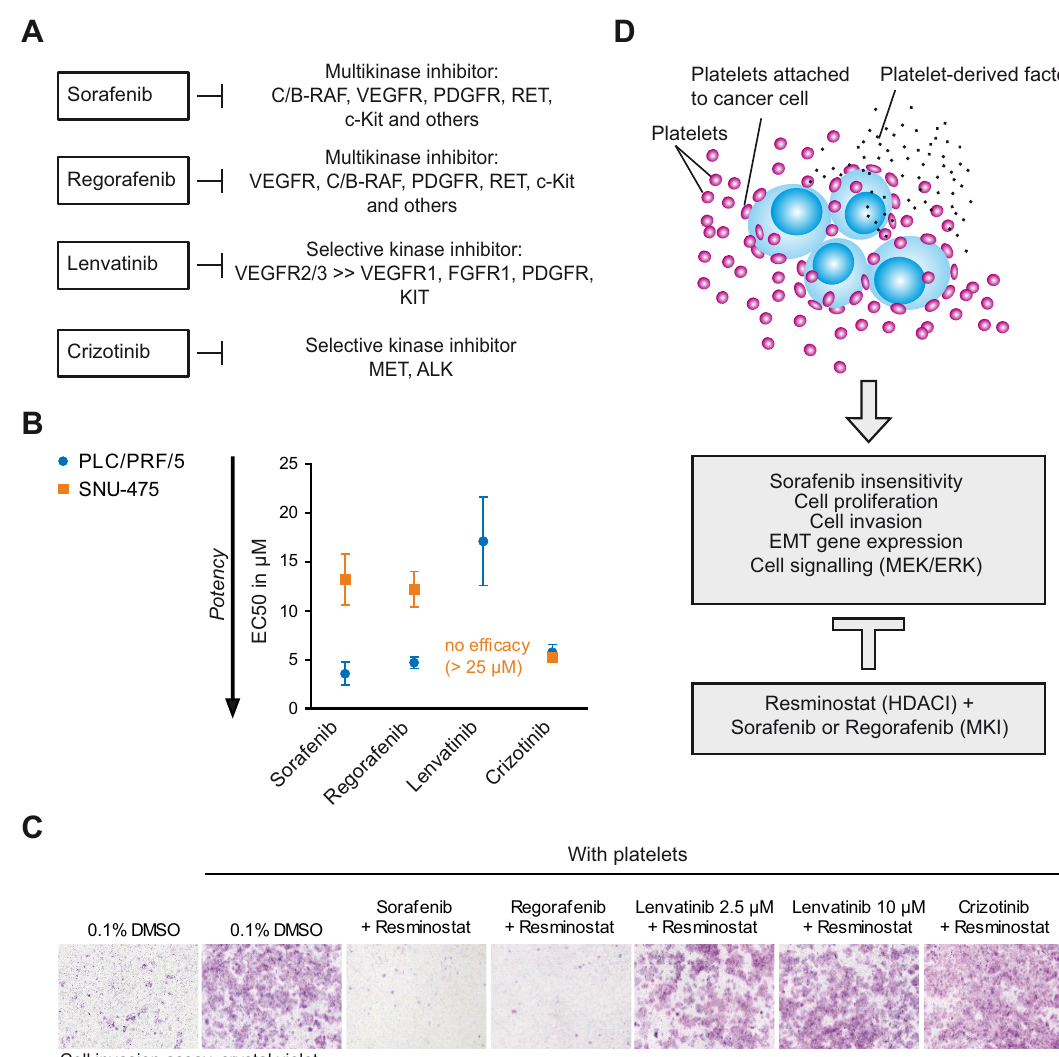
Figure 6. Resminostat in combination with the MKi sorafenib or regorafenib reversed platelet-induced cellular invasion of HCC cells. ( A ) Schematic presentation of the kinase inhibitor profile of sorafenib, regorafenib, lenvatinib and crizotinib. ( B ) EC50 values for the anti-proliferative activities of kinase inhibitors sorafenib, regorafenib, crizotinib and lenvatinib in PLC/PRF/5 and SNU-475 cells. The data are presented as mean ± SD (n = 3). ( C ) Invasion assay of PLC/PRF/5 with platelets. Resminostat in combination with several kinase inhibitors; sorafenib, regorafenib, lenvatinib and crizotinib. A representative experiment is shown. ( D ) Model: Inhibition of platelet-mediated cancer-promoting effects by the drug combination of resminostat and the MKi sorafenib or